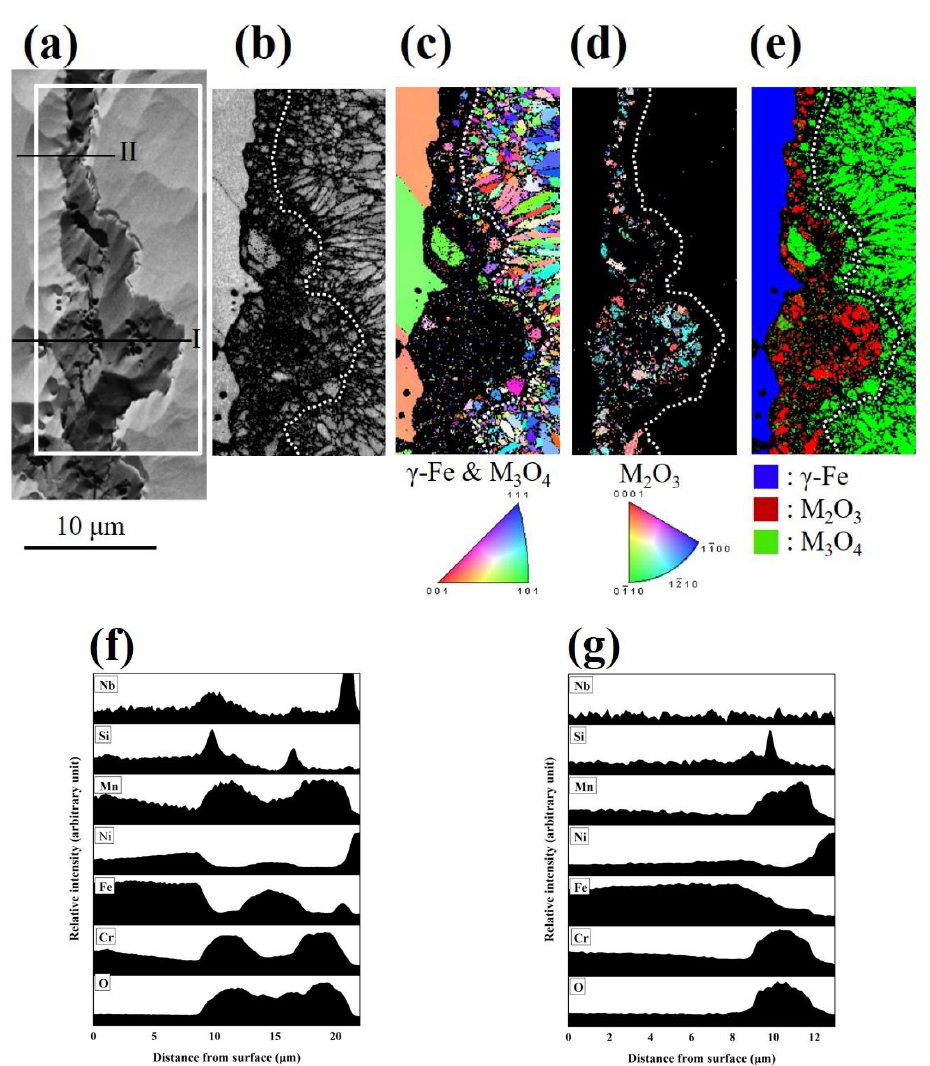
Figure 7. ( a ) FSD image, ( b ) image quality map, ( c ) inverse pole figure map for γ and M 3 O 4 phases, ( d ) inverse pole figure map for M 2 O 3 phase, and ( e ) phase map of the oxide layers in 22Cr25NiWCoCu stainless steel with 0.58% Nb after oxidation in ambient air for 150 h. ( f ) EDS line scan of Si, Mn, Ni, Fe, Cr, and O along lines I and II in ( a ) and ( g ) EDS line scan of Si, Mn, Ni, Fe, Cr, and O along line II in ( a ).